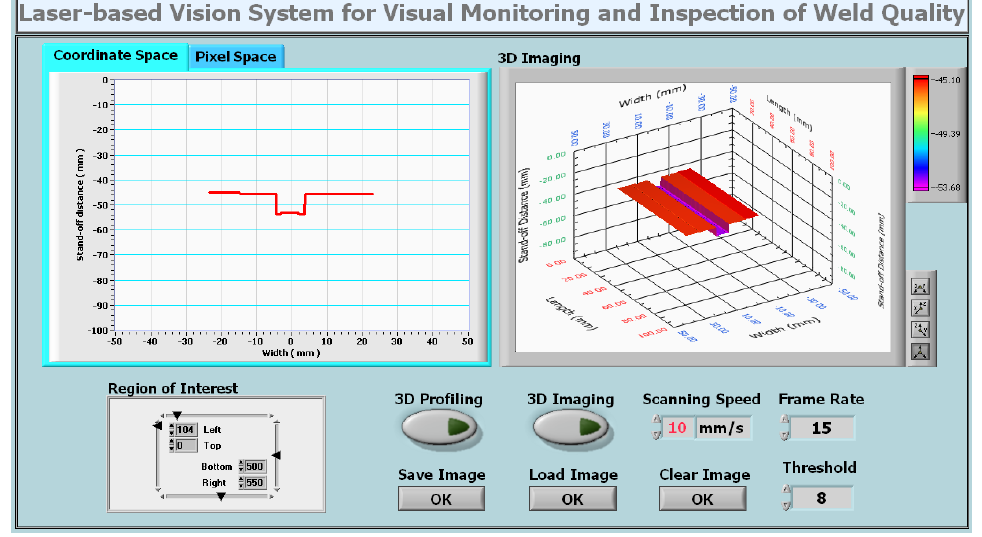
Figure 3. Human-machine interface of the laser-based vision